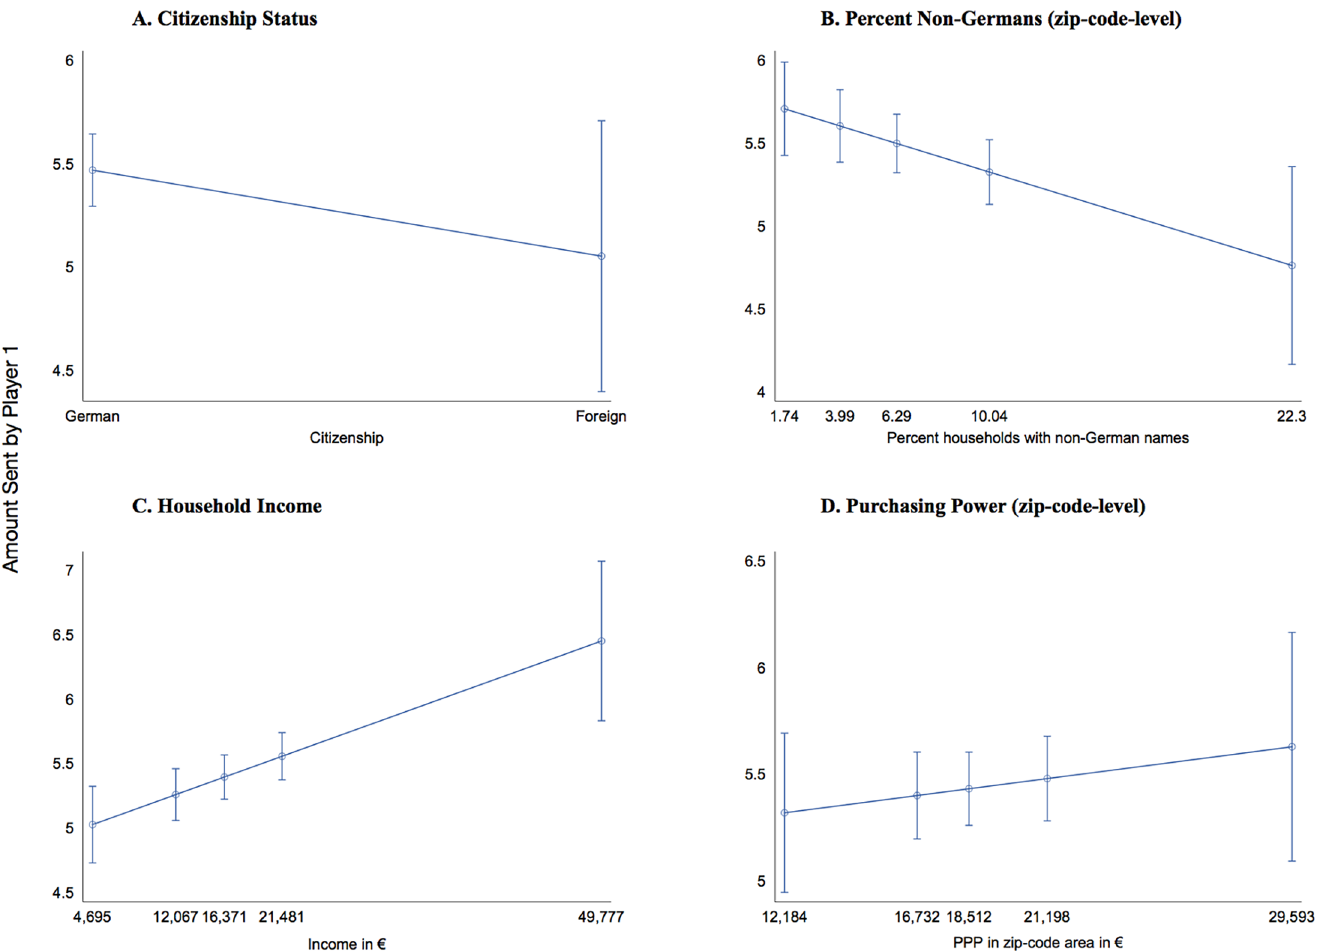
Fig 1. Predicted values for behavioral trust for individual- and zip-code-level indicators of socio-economic status and ethnic diversity. (A) Citizenship Status, (B) % non-Germans (zip-code level), (C) Household Income, (D) Purchasing Power (zip-code level) for the 1%, 25%, 50%, 75% and 99% percentile (full models with